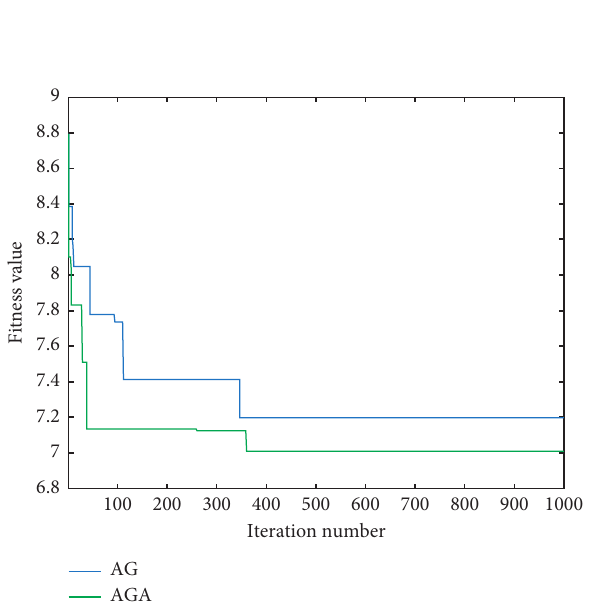
Figure 8: The convergence curves of GA and AGA.